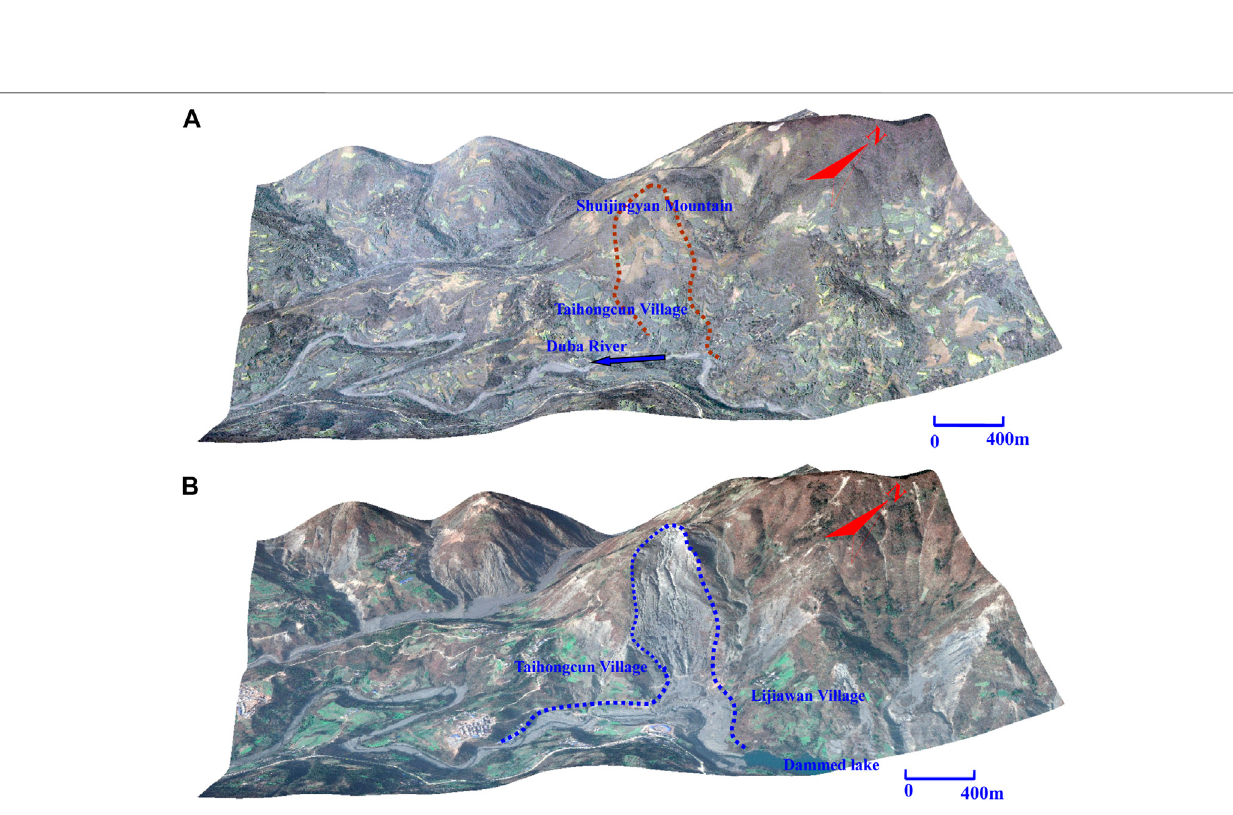
Frontiers in Earth Science |